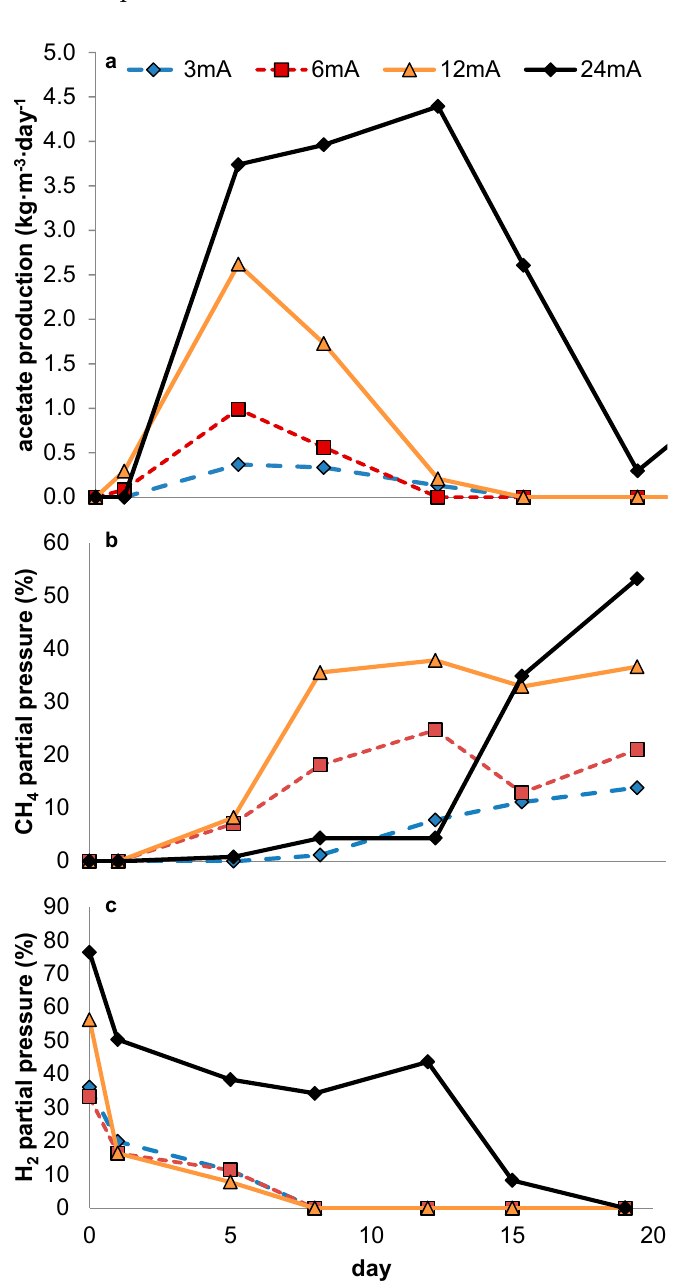
Figure 3. Results obtained from four biocathodes controlled at different current densities (3, 6, 12 and 24 mA corresponding to 1.3, 2.6, 5 and 11 A·m − 2 , respectively): ( a ) Observed acetate production rates as calculated from effluent concentration measurements show a clear effect of current density; while ( b ) methane partial pressures; and ( c ) hydrogen partial pressures as measured by head space gas analysis indicate progressive loss of electrons to methane as hydrogen partial pressure decreases.